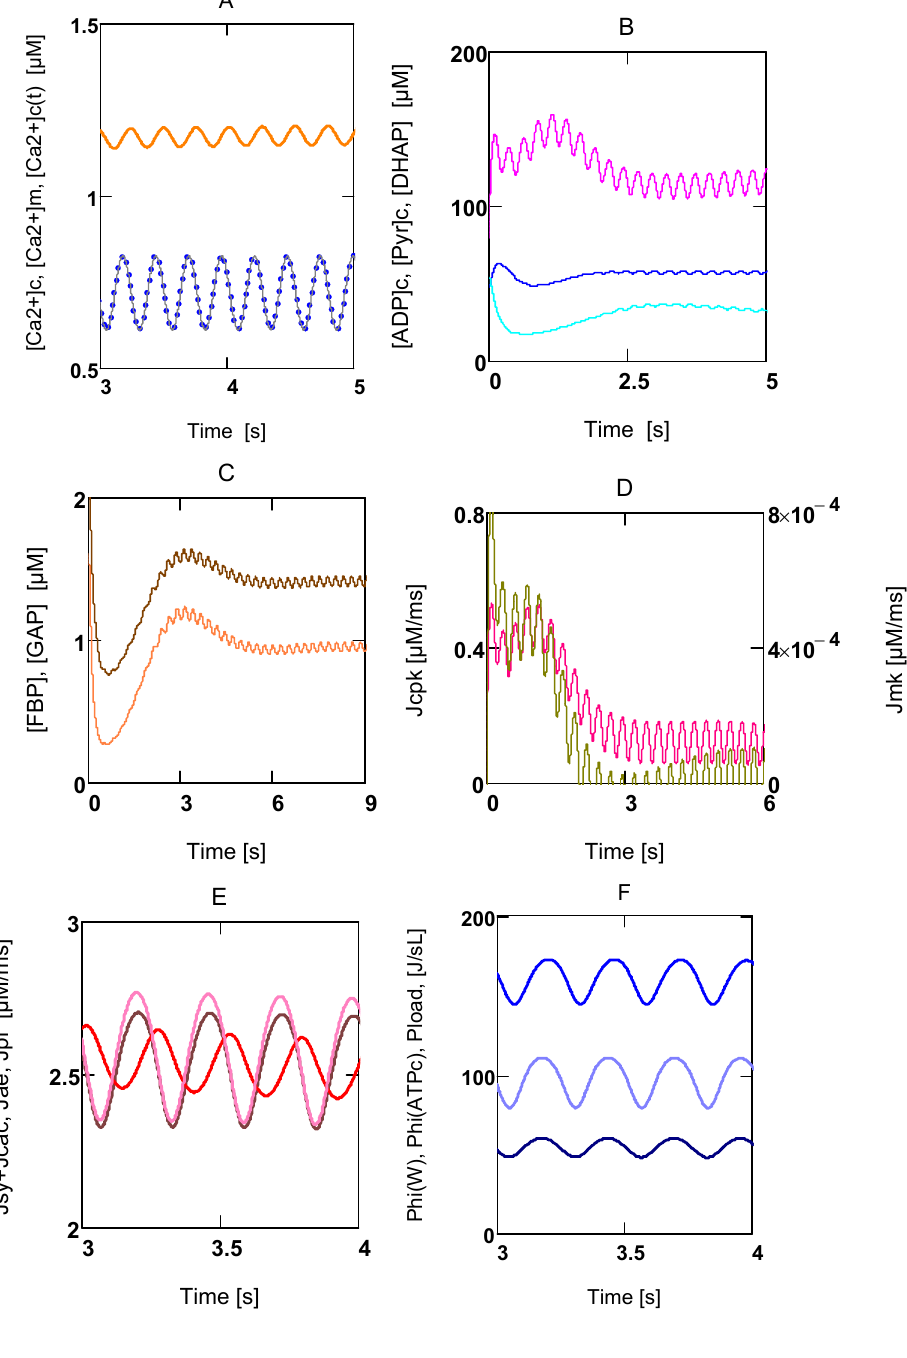
Figure 7. Forced oscillations produced by [Ca 2+ ] (grey)[Ca 2+ ] , (orange)[Ca 2+ ] , (blue points) oscillations according to A20; B: (red)[ADP] c m (cyan)[Pyr] , (blue)[DHAP]; C: (light-brown)[FBP], (dark-brown)[GAP]; D: (red) J c after about 30 s this flux oscillates around zero, (dark-green) J (black) J , (pink) J ; F: (dark-blue) dissipation function  AE Pi dissipation function p  (Phi(ATPc)), (blue) power output W